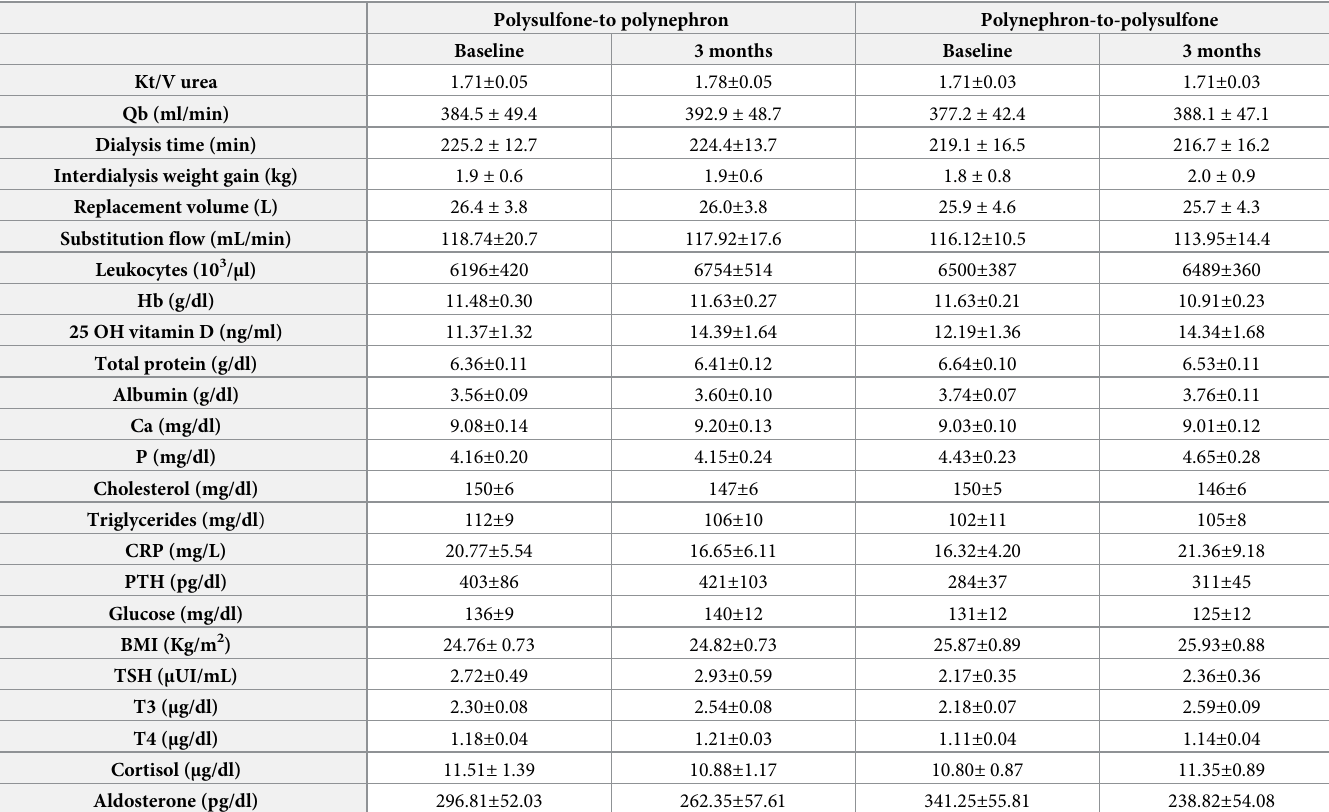
Table 1. Summary of clinical and biochemical